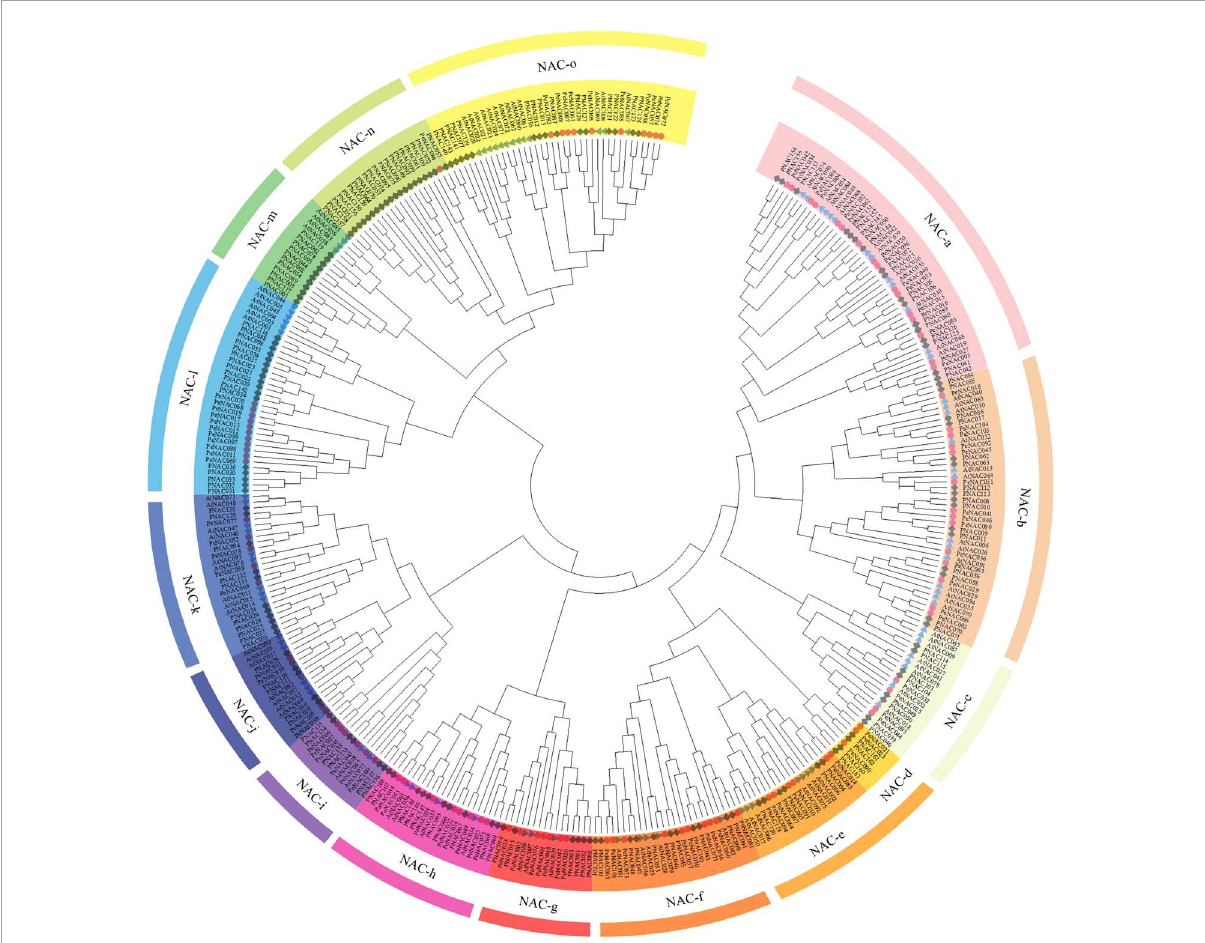
FIGURE1 An unrooted neighbor-joining (NJ) phylogenetic tree based on NAC protein sequence alignment between A. thaliana (AtNAC), P. edulis (PeNAC), and P. trichocarpa (PNAC) with 1000 bootstraps. All the NAC members were divided into 15 groups and presented in different colors. The blue triangle represents AtNAC sequences, the red circle represents PeNAC sequences and the gray square represents PNAC sequences.